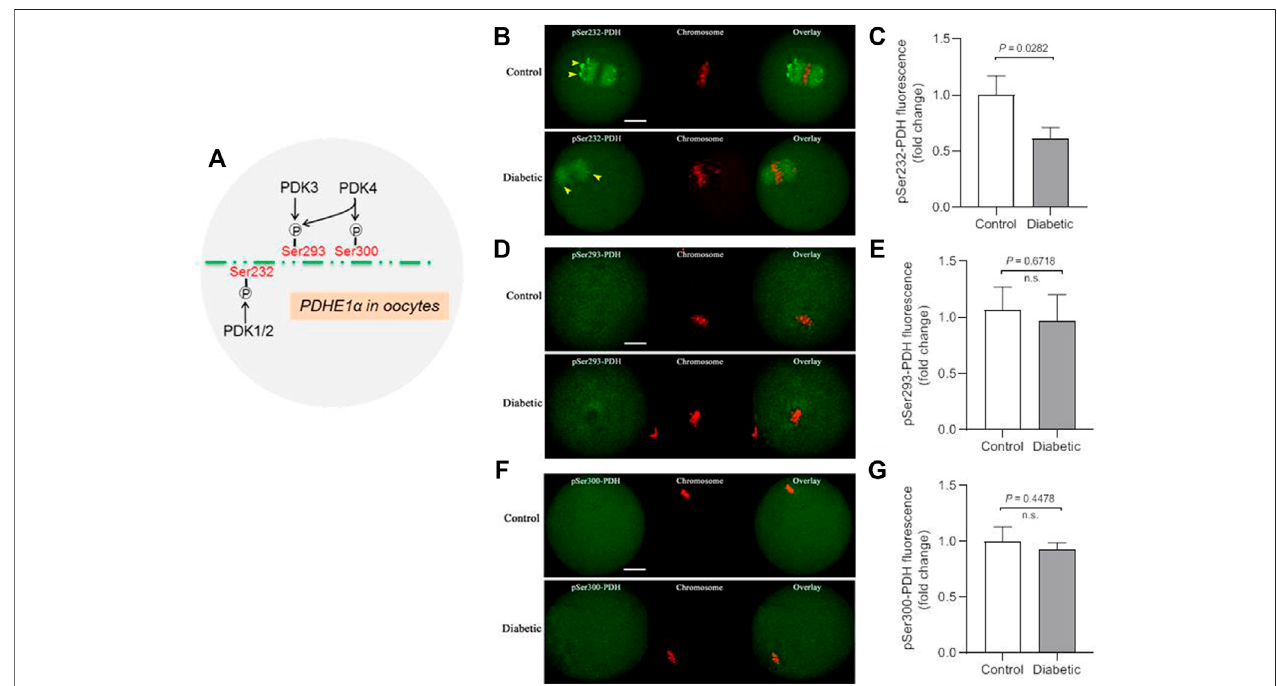
FIGURE2| Lowered phosphorylation levelofSer232-PDHE1 α inoocytes fromdiabeticmouse. (A) Schematicrepresentation ofthePDKparalog phosphorylation site speci fi city for oocyte PDHE1 α . (B) Representative images of control and diabetic oocytes stained with antibodies against pSer232-PDHE1 α (green) and co-stained with Propidium Iodide (PI, red) for chromosome. (C) Quanti fi cation of pSer232-PDHE1 α fl uorescence show in (B) . (D) Representative images of control and diabetic oocytes stained with antibodies against pSer293-PDHE1 α (green) and co-stained with PI (red) for chromosome. (E) Quanti fi cation of pSer293-PDHE1 α fl uorescence show in (D) . (F) Representative images of control and diabetic mouse oocytes stained with antibodies against pSer300-PDHE1 α (green) and co-stained with PI (red) for chromosome. (G) Quanti fi cation of pSer300-PDHE1 α fl uorescence show in (F) . Yellow arrowheads point to the pSer232-PDH signal in control and diabetic oocytes. Scale bar: 20 µm. At least 30 oocytes for each group were analyzed, and the experiments were repeated three times. Error bars indicate ± SD, a Student ’ s t test was used for statistical analysis. n.s., not signi fi cant.